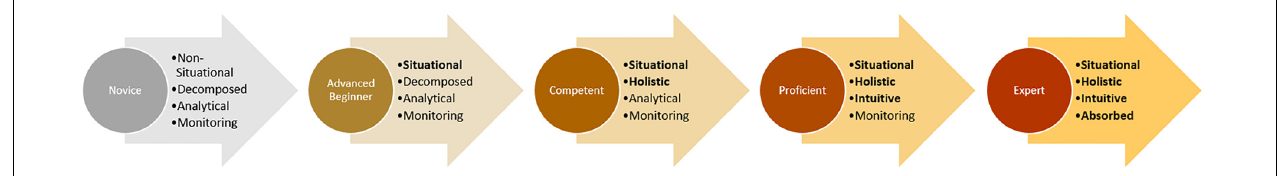
FIGURE 1 | The Dreyfus model of skill acquisition. Skill levels are labeled in the circles and associated states of the four cognitive parameters are written in the arrows. Cognitive parameters in which subjects have achieved the more advanced state are highlighted with bold